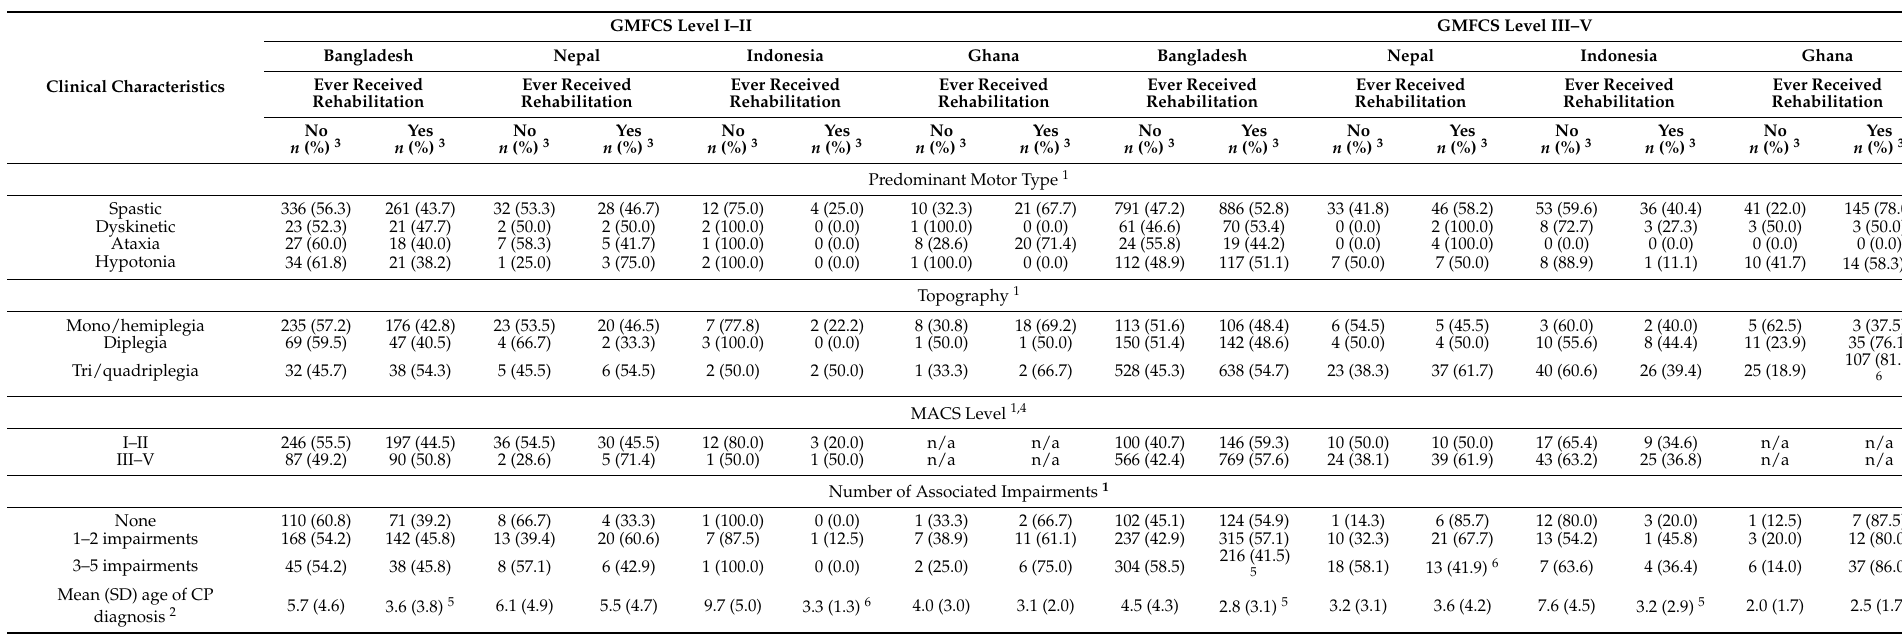
Table 4. Distribution of clinical factors of children with CP according to their GMFCS level and rehabilitation status in Bangladesh, Nepal, Indonesia, and Ghana.